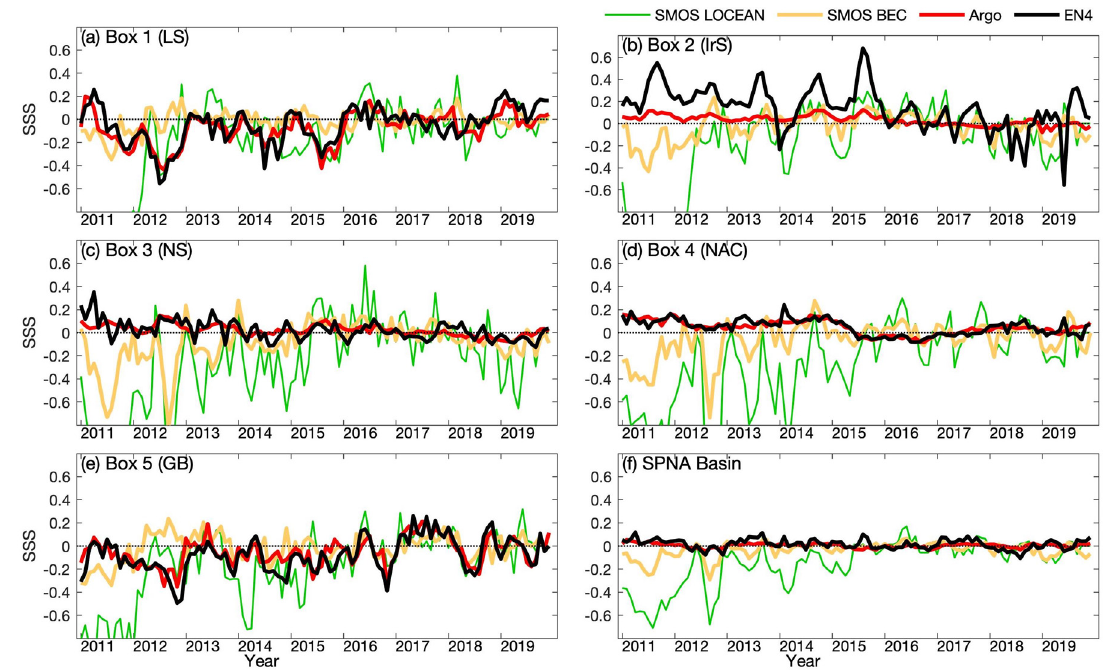
Figure 10. Monthly mean time series of SSS anomalies at the five boxed areas ( a – e ) and over the SPNA ( f ) during 2011–2019 for four products, SMOS LOCEAN, SMOS BEC, Argo, and EN4. The anomalies are referenced to the combined annual and semiannual modes of the harmonic analysis of the 2016–2018 period.